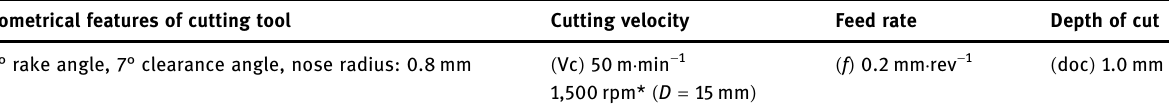
Table 3: Machining operation conditions Geometrical features of cutting tool Cutting velocity Feed rate Depth of